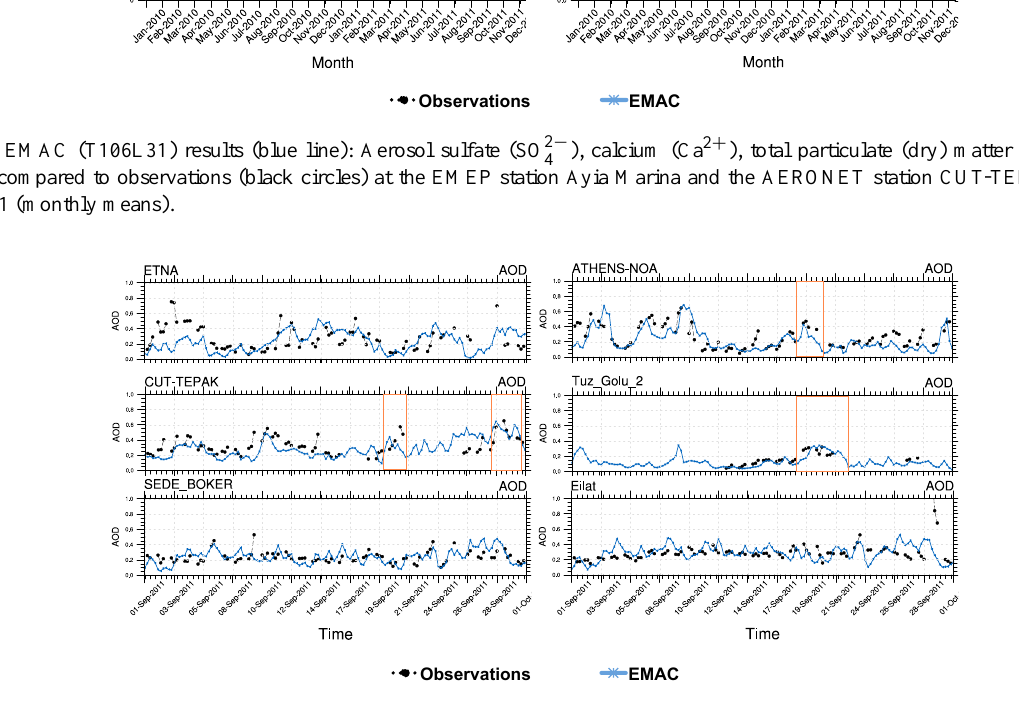
Figure 4. EMAC (T255L31) model results (blue line) of AOD (550nm) and AERONET observations (black dots). The orange boxes delineate the dust outflow events.